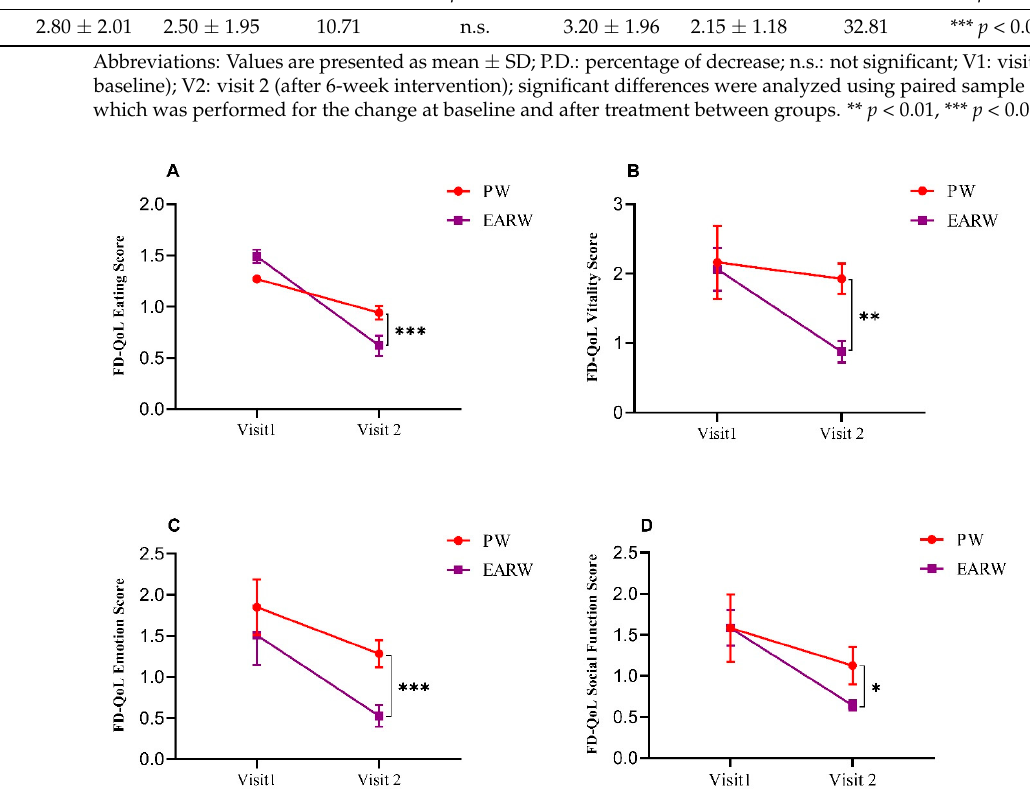
NDI-K score was measured at baseline (visit 1) and post-intervention (visit 2) for the EARW and PW groups. Our result showed that the total NDI-K score in the EARW group (Pre; 2.20 ± 0.49, Post; 1.05 ± 0.29, P.D%; 52.27%) was significantly lower (F = 9.11, p < 0.01) than that in the PW (Pre; 2.11 ± 0.54, Post; 1.35 ± 0.33, P.D%; 36.25%) group at visit 2 (Figure